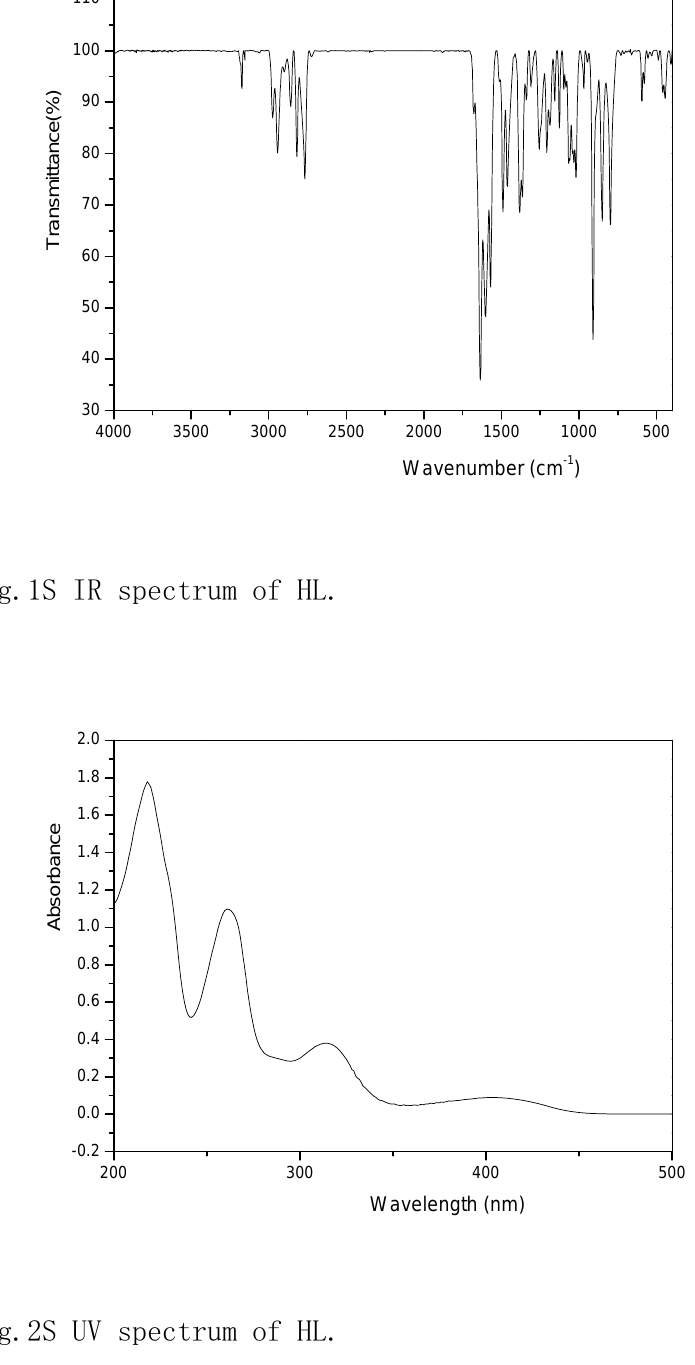
Fig.2S UV spectrum of